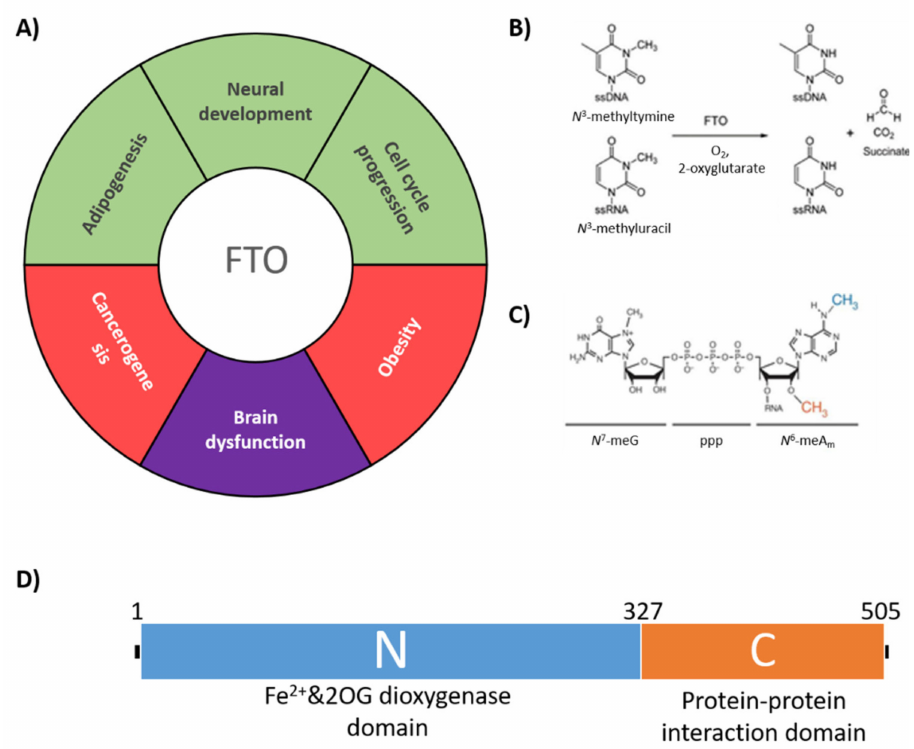
Figure 1. FTO architecture, specificity and functions. ( A ) Physiological functions affected by FTO. Green—physiological processes. Red—defects caused by FTO over-activity. Purple—defects caused by deficit of FTO activity; ( B ) demethylation reaction performed by FTO; ( C ) N 6 -meA m —the preferred FTO substrate (description in the text); ( D ) domain architecture of FTO